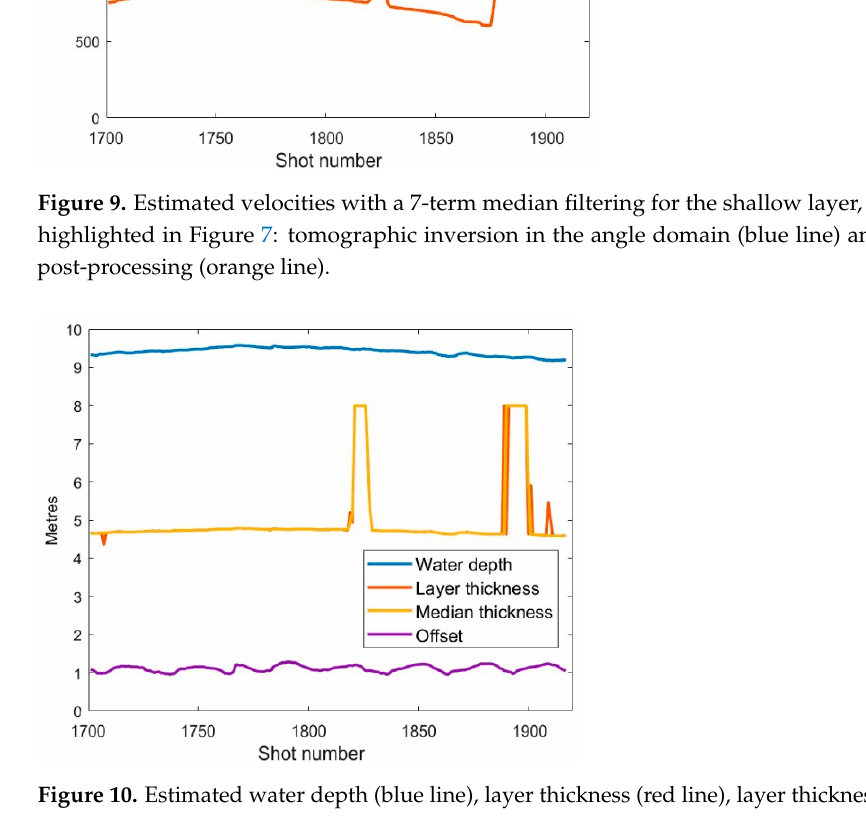
Figure 9. Estimated velocities with a 7-term median filtering for the shallow layer, within the area highlighted in Figure 7: tomographic inversion in the angle domain (blue line) and with the Dix post-processing (orange line).